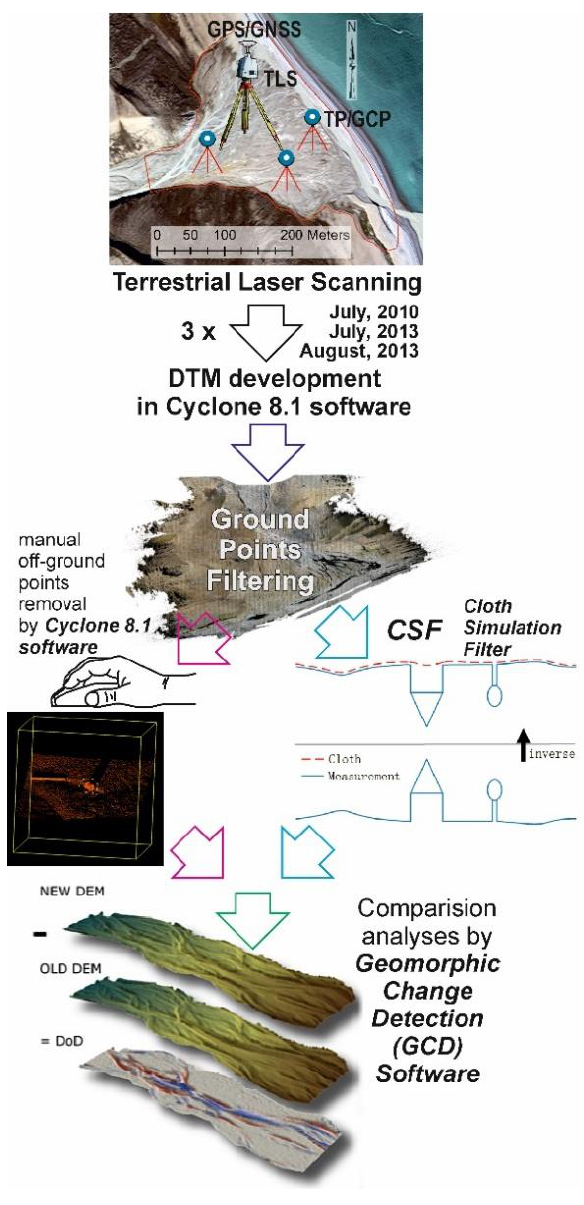
Figure 2. Framework of research method. Sources: Cloth Simulation Filter (CSF) diagram [28], Geomorphic Change Detection (GCD) diagram http://gcd.riverscapes.xyz, [13,15].